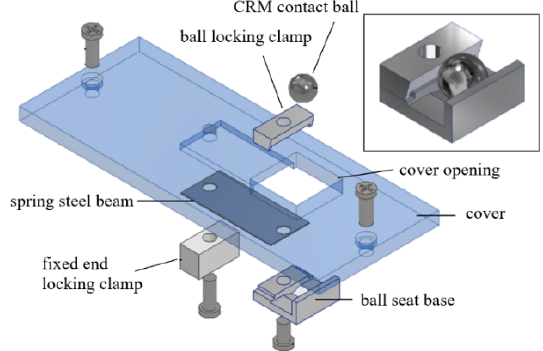
Figure 29. Design of the Contact Relay Mechanism in exploded view.